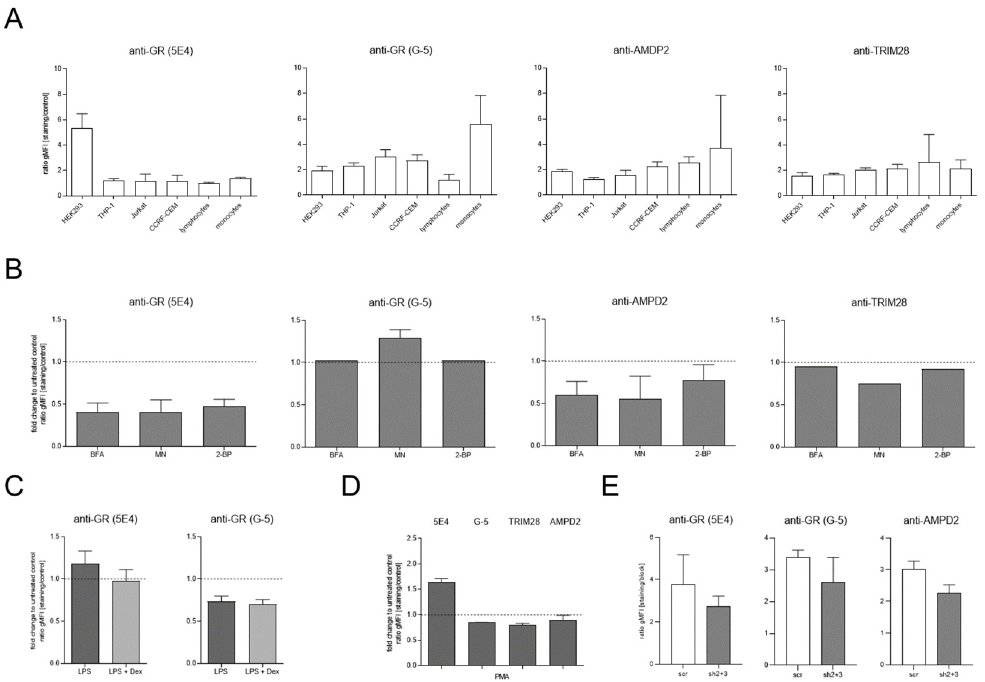
Figure 4. Independent validation of anti-GR (5E4) antibody specificity. ( A ) Multiple cell lines and primary human immune cells were cross-evaluated by flow cytometry. Surface stainings were performed using antibodies directed against GR, AMPD2, and TRIM28, as indicated (n = 3–32). The cells were gated according to Supplementary Figure S1A,B for analysis. r gMFI represents the ratio of geometric mean fluorescence intensity of staining to unstained control. ( B ) Surface expression of GR, AMPD2, and TRIM28 on HEK293 cells after inhibition of Golgi transport and protein palmitoylation. HEK293 cells were incubated with 1 μ g/mL BFA, 0.5 μ g/mL MN, and 100 μ g/mL 2 BP, respectively, for 24 h, and surface expression was measured by flow cytometry (n = 1–9). The cells were gated according to Supplementary Figure S1A for analysis. r gMFI represents the ratio of geometric mean fluorescence intensity of staining to unstained control. Modification by inhibition of Golgi transport and protein palmitoylation is depicted in relation to untreated control samples. ( C ) Surface expression of the GR was evaluated by flow cytometry using antibody clones, 5E4 and G-5, after immunostimulation. CD14+ monocytes were isolated by magnetic cell separation and incubated with 1 μ g/mL LPS ± 10-5 M Dex for 24 h, and surface expression was measured by flow cytometry (n = 2). The cells were gated according to Supplementary Figure S1C for analysis. The data are depicted in relation to untreated control samples. ( D ) Surface expressions of GR, AMPD2, and TRIM28 were evaluated by flow cytometry after immunostimulation. THP–1 cells were incubated with 10 ng/mL PMA for 24 h, and surface expression was measured by flow cytometry (n = 2–8). The cells were gated according to Supplementary Figure S1A for analysis. Modification by immunostimulation is depicted in relation to untreated control samples. ( E ) Surface expression of GR and AMPD2 after GR knockdown was evaluated by flow cytometry (n = 2–3). HEK293 cells stably expressed the indicated shRNA constructs. The cells were gated according to Supplementary Figure S1A for analysis. r gMFI represents the ratio of geometric mean fluorescence intensity of staining to unstained control. Bar graphs depict median and interquartile range. Legend: 2-BP, 2-bromohexadecanoic acid; BFA, brefeldin A; Dex, dexamethasone; LPS, lipopolysaccharide; MN, monensin; scr,